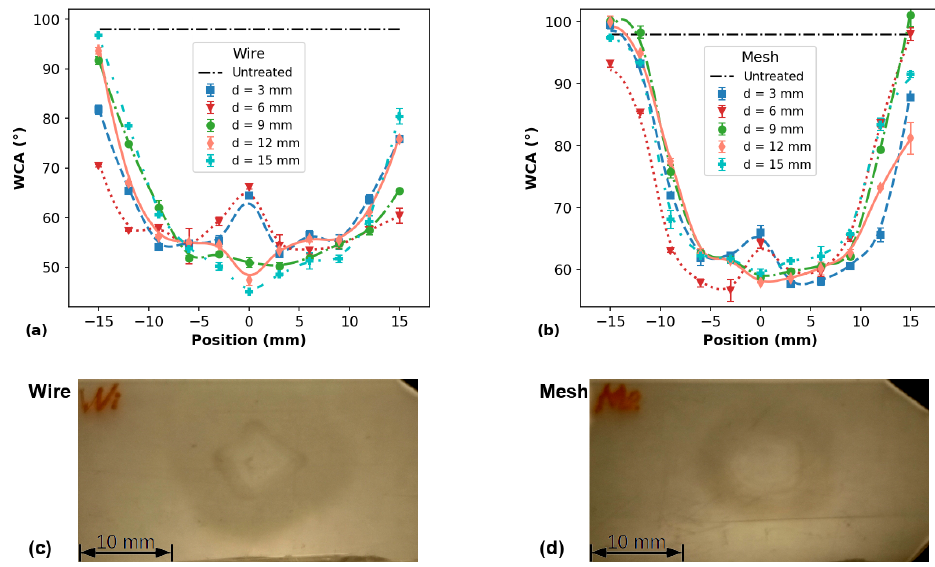
Figure 7. WCA profiles on PP surfaces measured for different distances between plasma outlet and target for ( a ) wire and ( b ) mesh configurations and corresponding photos of PP samples treated with ( c ) wire and ( d ) mesh when d = 6.0